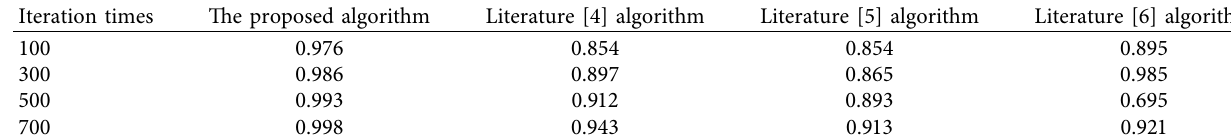
Table 2: Comparison of feature extraction accuracy.